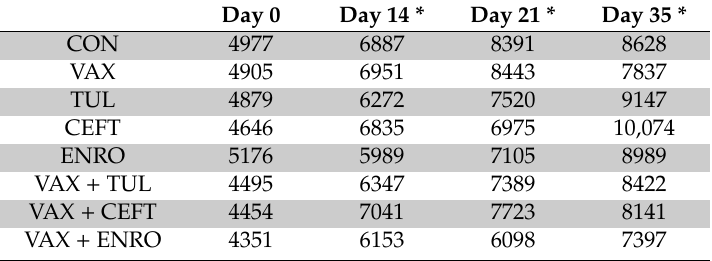
Table 1. Mean total lymphocyte counts for each treatment group at days 0, 14, 21, and 35. Unvaccinated control animals (CON), vaccination only (VAX), tulathromycin only (TUL), ceftiofur only (CEFT), enrofloxacin only (ENRO) or the combination of the PCV-2 / M. hyopneumoniae vaccine with the antibiotics (VAX + TUL, VAX + CEFT, VAX + ENRO). There was no di ff erence when each group was compared to each other at days 0, 14, 21, and 35. However, there was a significant di ff erence within each group over time (days 14, 21, and 35, p < .05, asterisks).